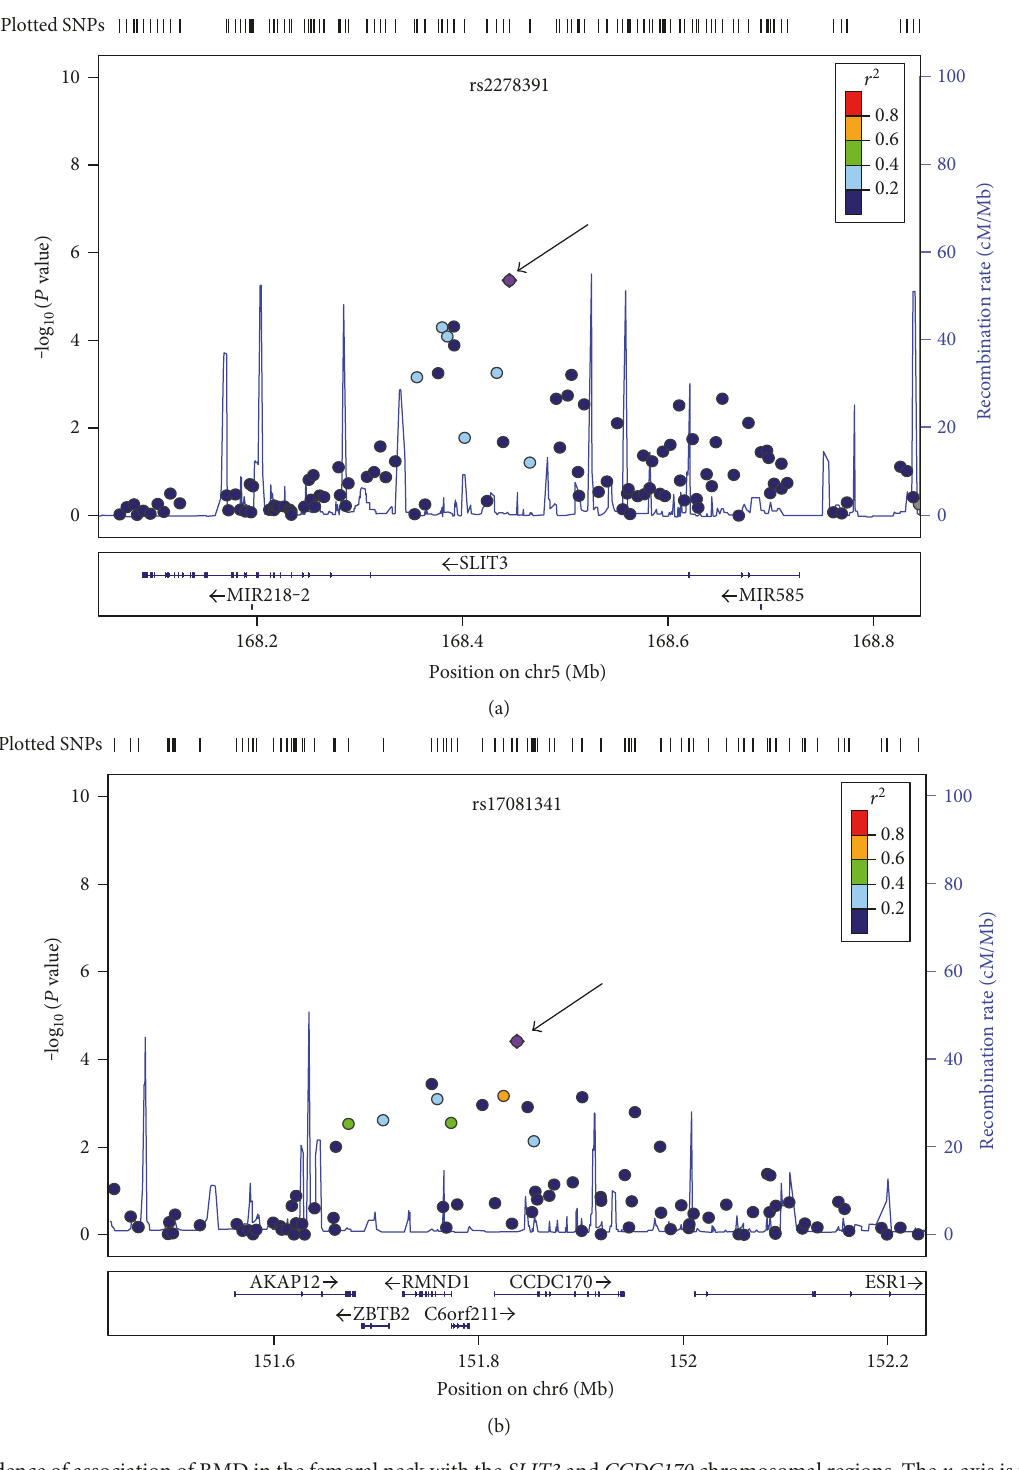
Figure 1: Evidence of association of BMD in the femoral neck with the SLIT3 and CCDC170 chromosomal regions. The x -axis is the physical position on the chromosome (Mb), and the y -axis denotes the association test result as the − log ( P value). SNPs are color-coded according to the linkage disequilibrium (LD) with the lead SNP (purple diamond) indicated by the arrow. (a) The SNP rs2278391 in the SLIT3 region; (b) the SNP rs17081341 in the RMND1/ CCDC170 region. The regional association plots in the Morelos cohort were generated using LocusZoom and only show genotyped